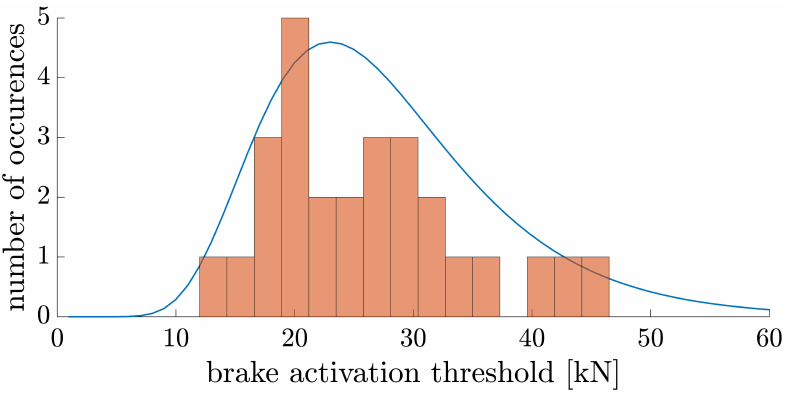
Figure 7. Distribution of experimentally measured brake-activation